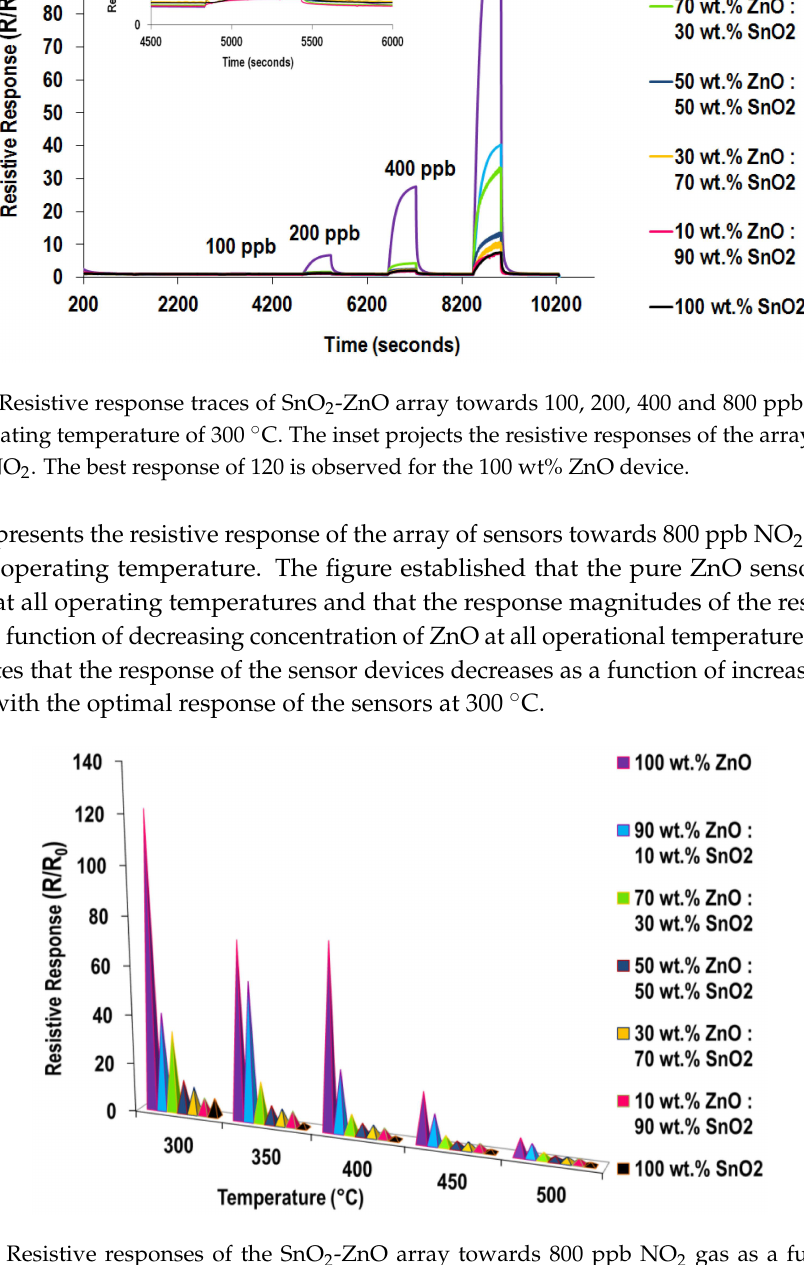
Figure 8. Resistive responses of the SnO 2 -ZnO array towards 800 ppb NO 2 gas as a function of increasing operating temperature. The best response of 120 is observed for the 100 wt% ZnO device at an operating temperature of 300 ˝